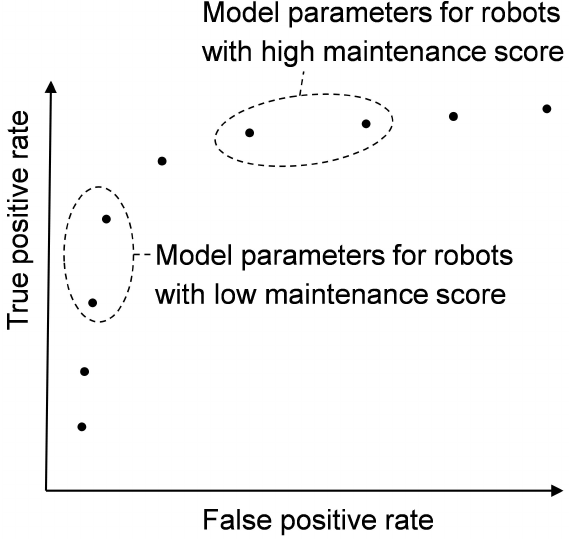
Figure 15. Selection of model parameters based on a maintenance